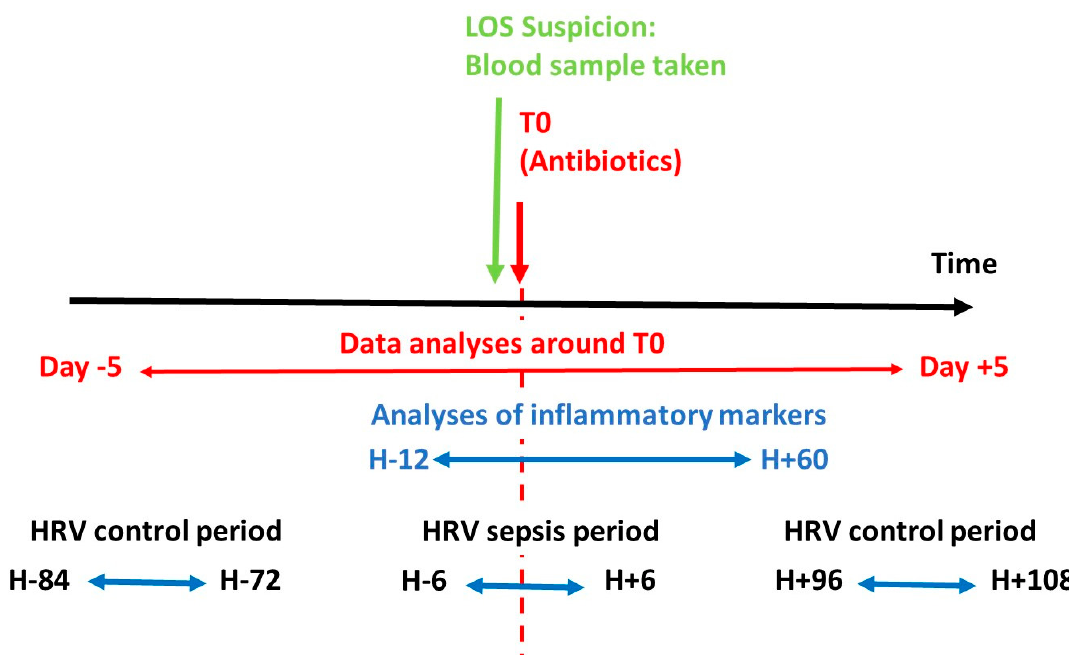
Figure 2. Time windows used for analyses. T0: start of administration antibiotics; period around infection was defined as five days before and five days after T0; the most extreme value of inflammatory markers were obtained between T0 − 12 h and T0 + 60 h; HRV: heart rate variability was studied on 12 h-period between T0 − 6 h and T0 + 6 h with reference values calculated over a period of 12 h outside of infectious episode (at least three days before or four days after T0). The results are presented in number and % or median (interquartile range, IQR) or mean (standard deviation, SD) depending on the distribution of the variables.